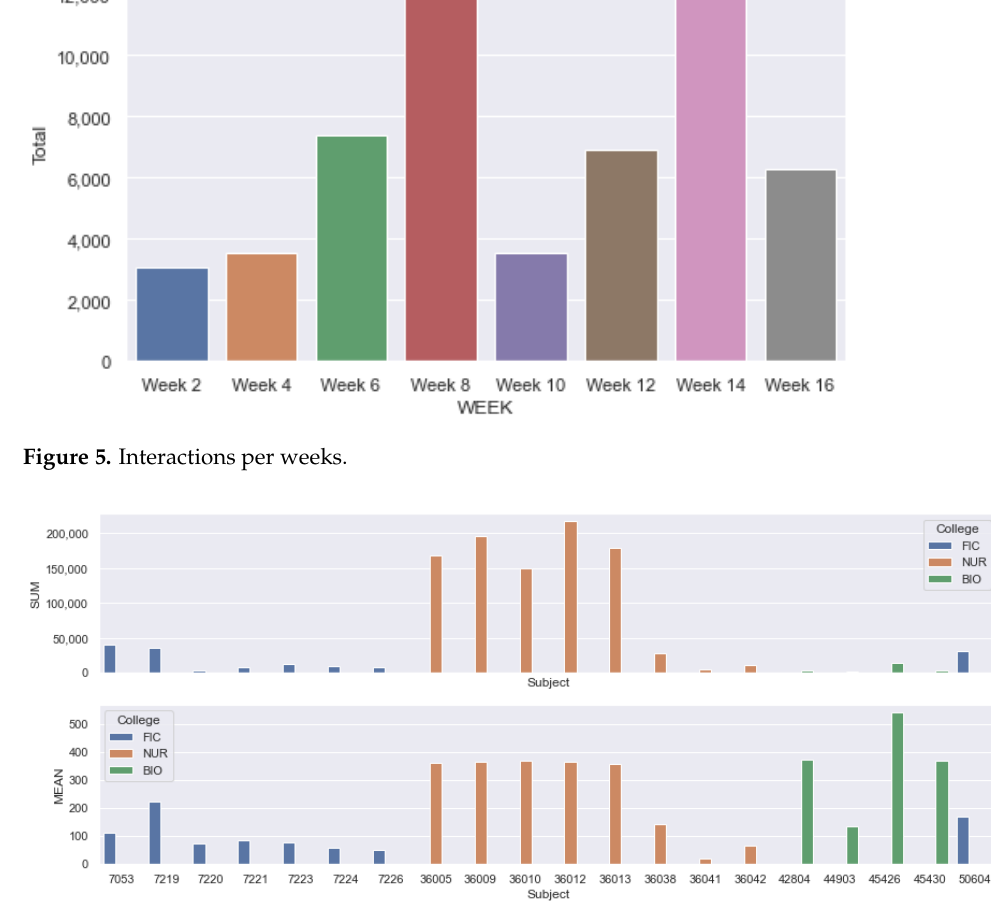
Figure 6. Sum and mean interactions by